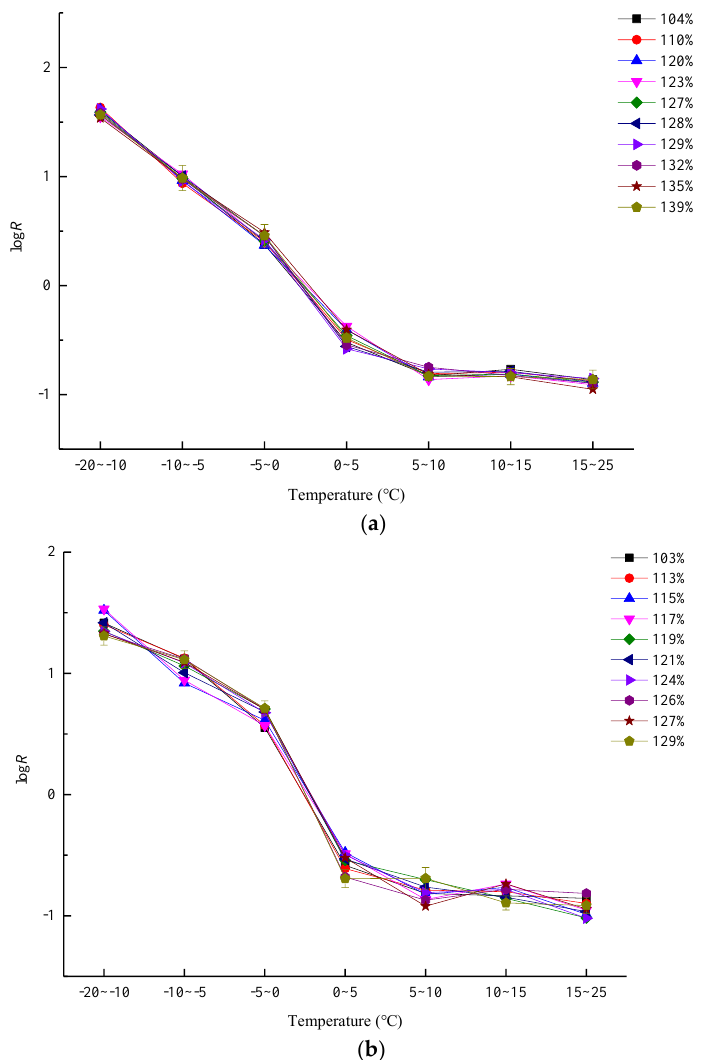
Figure 3. Effect of temperature on the logR in the cross-section of Populus simonii trees under different MCs. ( a ) Sound Populus simonii trees; ( b ) Decayed Populus simonii trees.